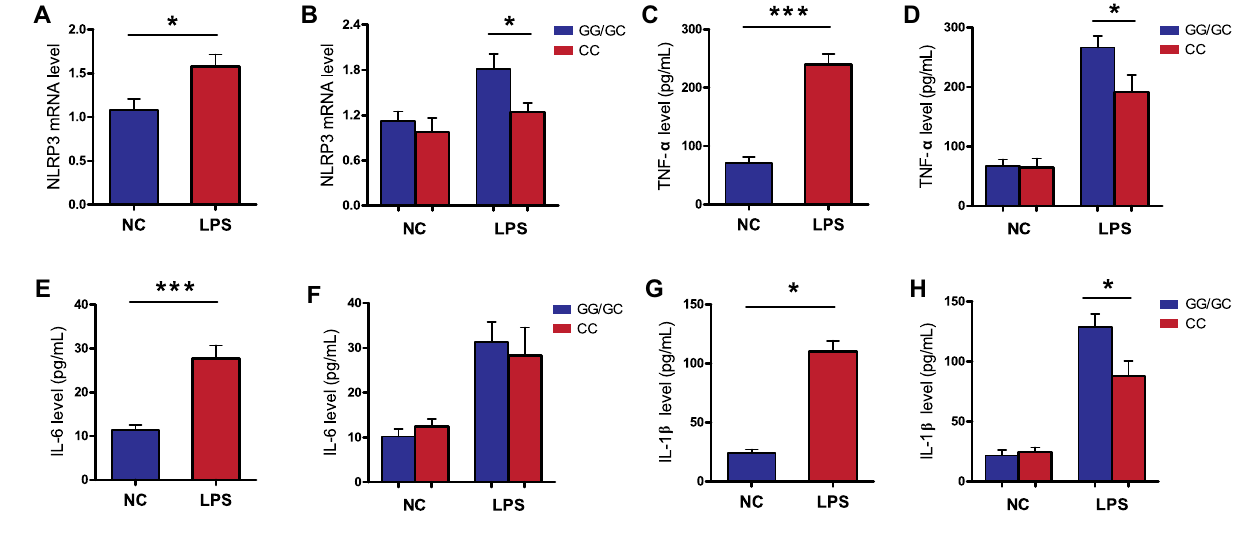
Figure 3. The rs10754558 polymorphism is associated with increased expression of NLRP3 gene and its downstream inflammatory cytokines in LPS-stimulated peripheral blood mononuclear cells (PBMCs). The PBMCs isolated from 50 healthy subjects with different rs10754558 genotypes were treated with 500 ng/mL of LPS (n = 25) and PBS (n = 25) as negative control. ( A , B ) The expression of NLRP3 were detected using qRT- PCR; The supernatant concentrations of TNF-α ( C , D ), IL-6 ( E , F ) and IL-1β ( G , H ) were measured by ELISA. LPS lipopolysaccharide, qRT-PCR quantitative real-time polymerase chain reaction, ELISA enzyme-linked immunosorbent assay. Values of relative expression levels are shown as mean ± SEM. * p < 0.05, *** p < 0.001.